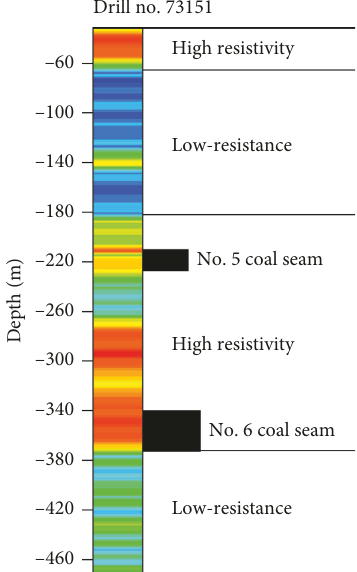
Figure 6: Column diagram of borehole resistivity in exploration area